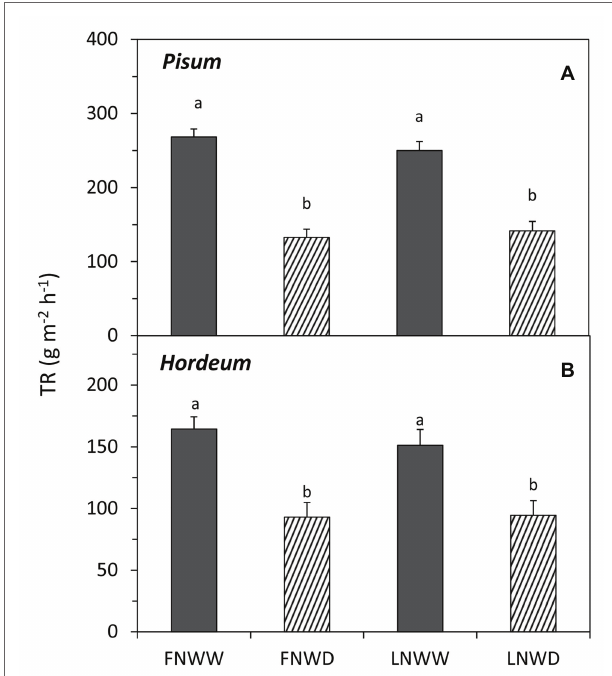
FIGURE 2 | Mean NO3 − content in leaf and root biomass of P. sativum (A) and H. vulgare (B) plants after 2–6 days treatment with different water